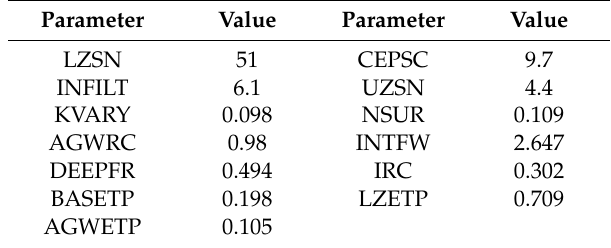
Figure 5. Observed and HPSF predictions of the flows at F3 during the stage of calibration and validation. Table 6. Calibrated parameters of the HSPF model identified by the NSGA ‐ II. Table 6. Calibrated parameters of the HSPF model identified by the NSGA-II.